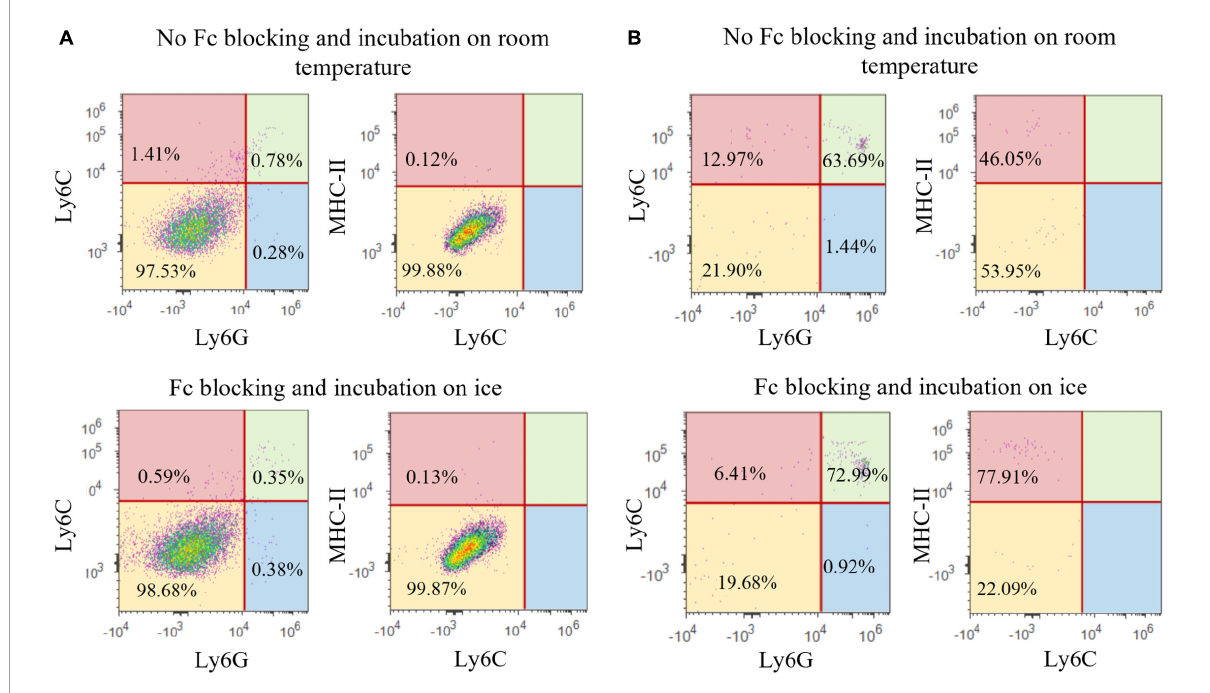
FIGURE9 Representative images of Ly6G, Ly6C, and MHC-II expression in CD11b + CD45 int population (A) and CD11b + CD45 high population (B)